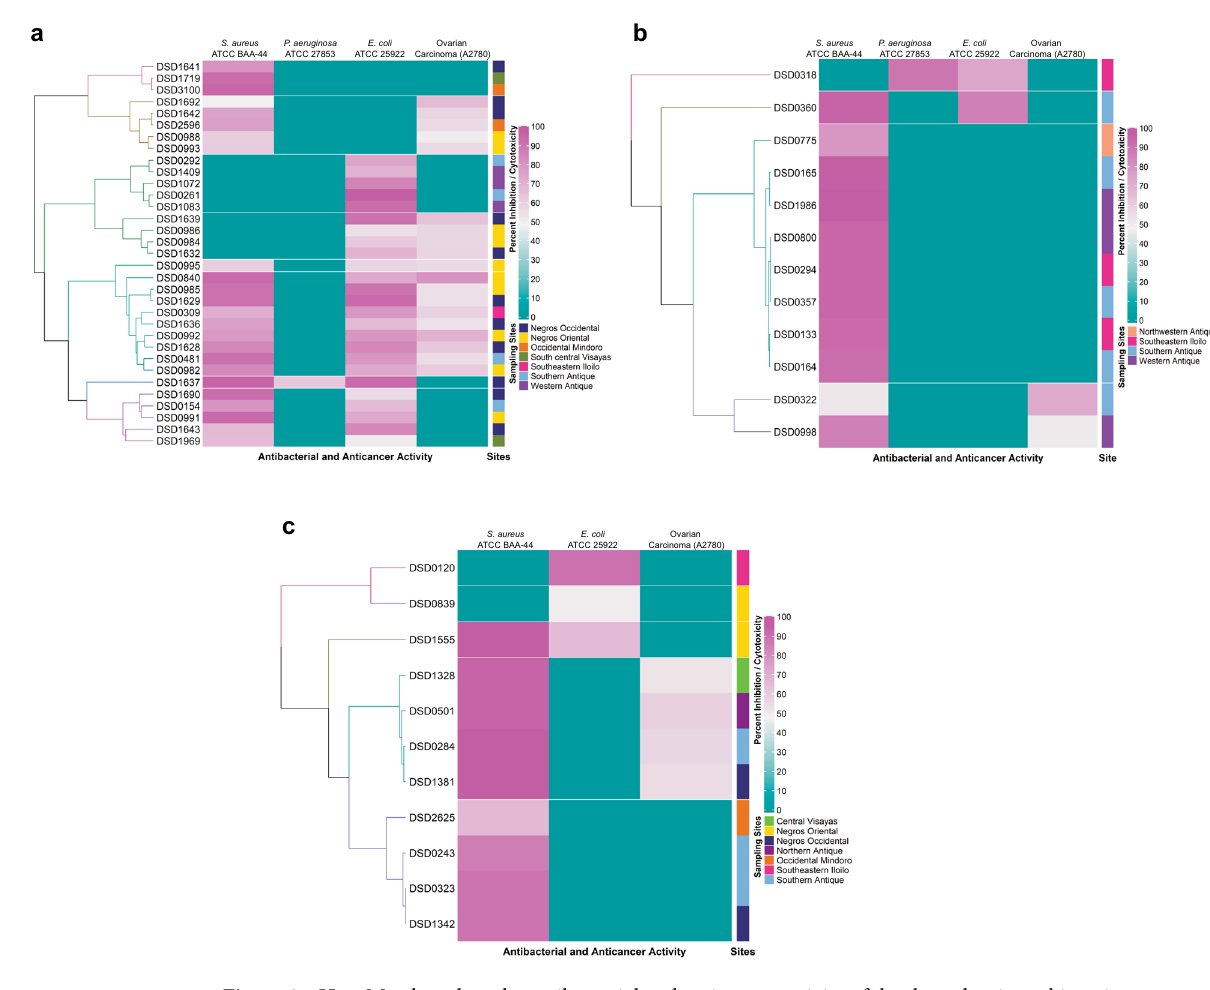
Figure 3. Heat Map based on the antibacterial and anticancer activity of the three dominant bioactive Streptomyces species, ( a ) S. parvulus , ( b ) S. enissocaesilis , and ( c ) S. rochei, against four test pathogens and ovarian cancer cell line (A2780). Dendrogram on the left of the diagram indicate the relatedness of the strains based on their bioactivities. Color gradient ranging from blue-green (0%), pink (50%), and purple (100%) corresponds to the antibacterial and cytotoxicity activity. Collection sites of strains were annotated by the color strips on the right-side tree of the diagram. The heat map was created using RStudio statistical program ver1.2.5042 with heat map clustering methods; hierarchical clustering Euclidean distance metric was used to cluster the